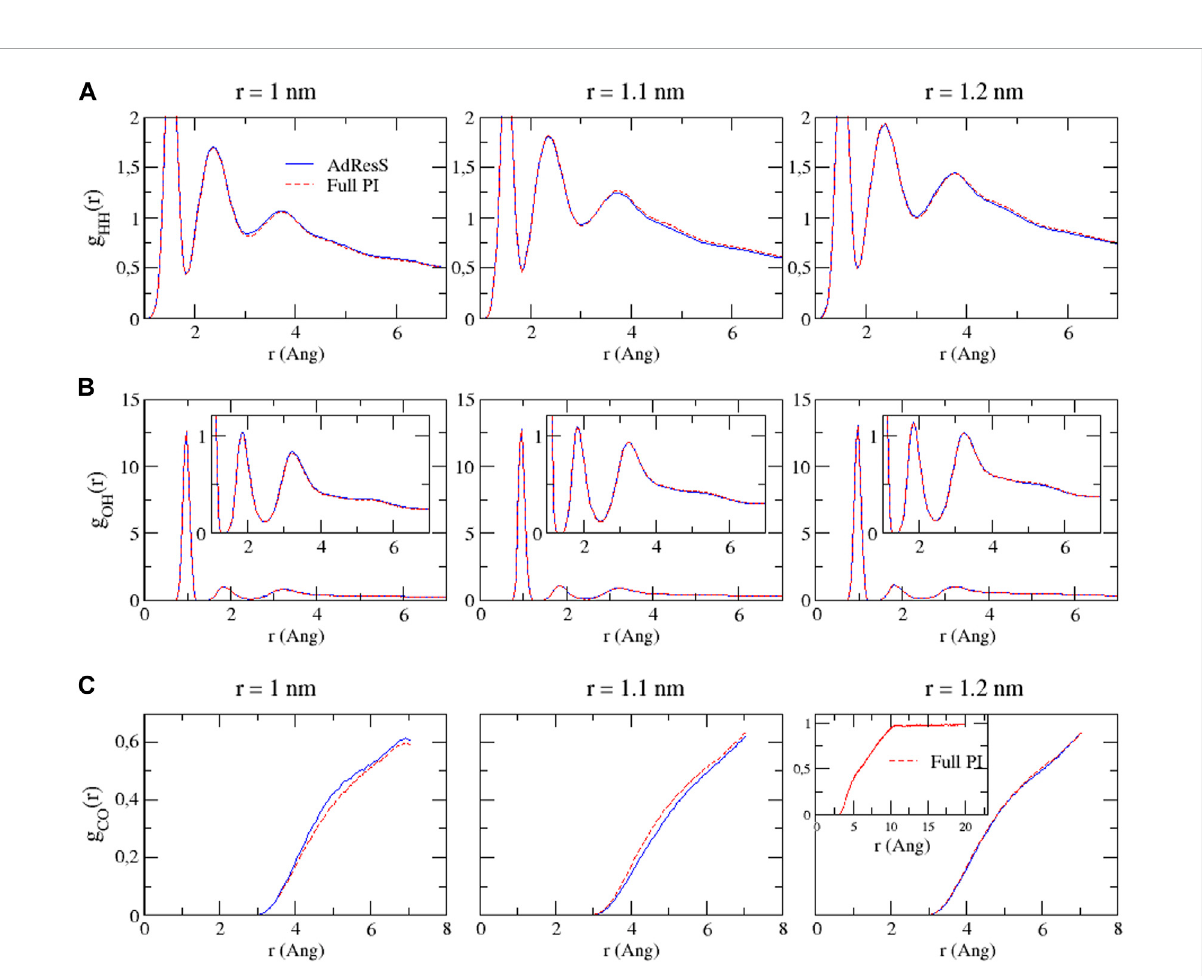
FIGURE 4 Bead – bead radial distribution functions for hydrogen – hydrogen (A) , oxygen – hydrogen (B) , and carbon – oxygen (C) calculated in the PI region of AdResS and the equivalent subregion of the reference simulation. Since these curves are calculated only in a subregion, they are not